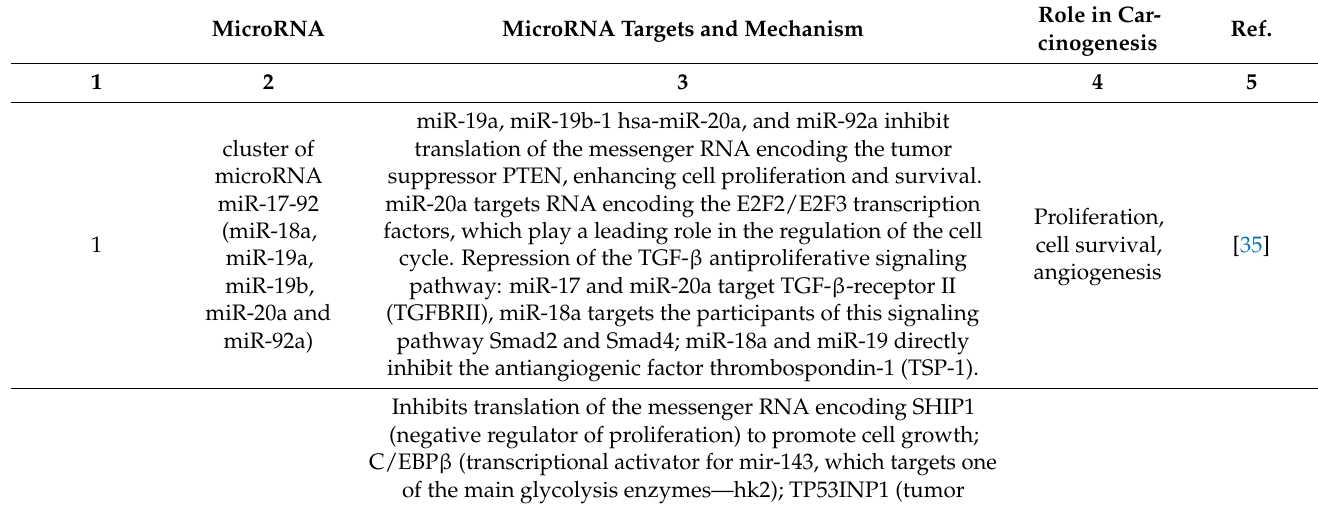
Table 1. OncomiRs in lung